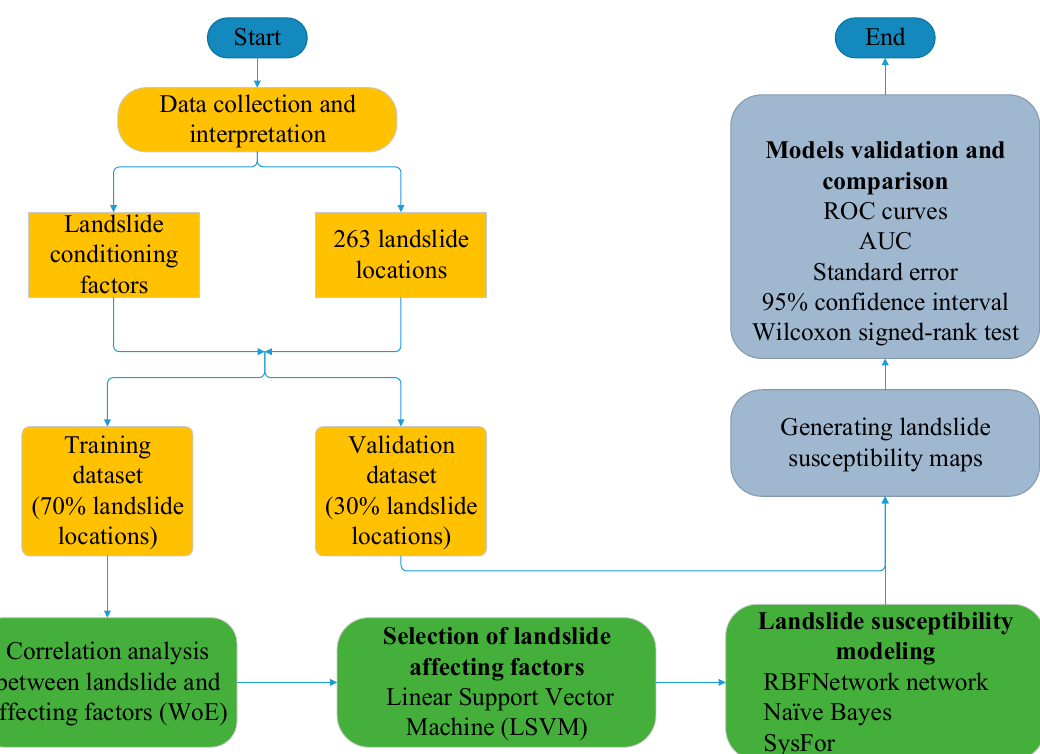
Figure 2. Flowchart of the study.